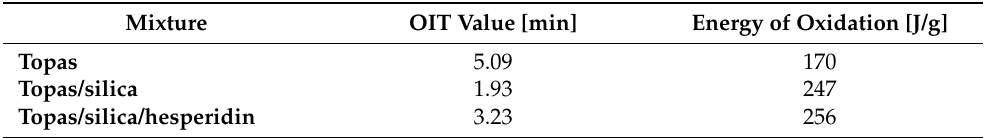
Table 5. Oxidation induction time values of Topas-based samples before aging and their energy of oxidation.